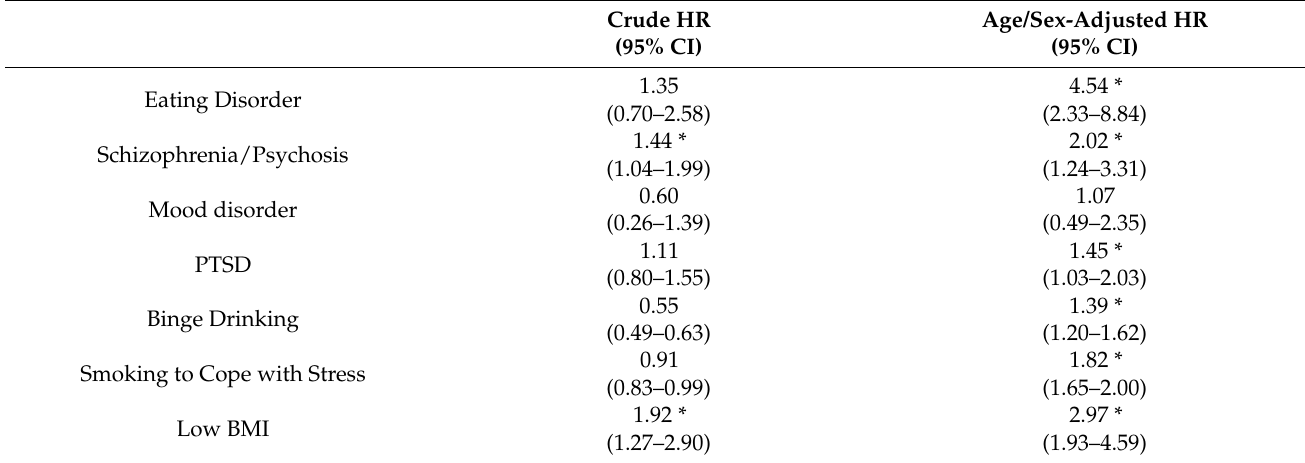
Table 2. Crude and age/sex-adjusted effect of the self-reported major mental health problems on mortality †